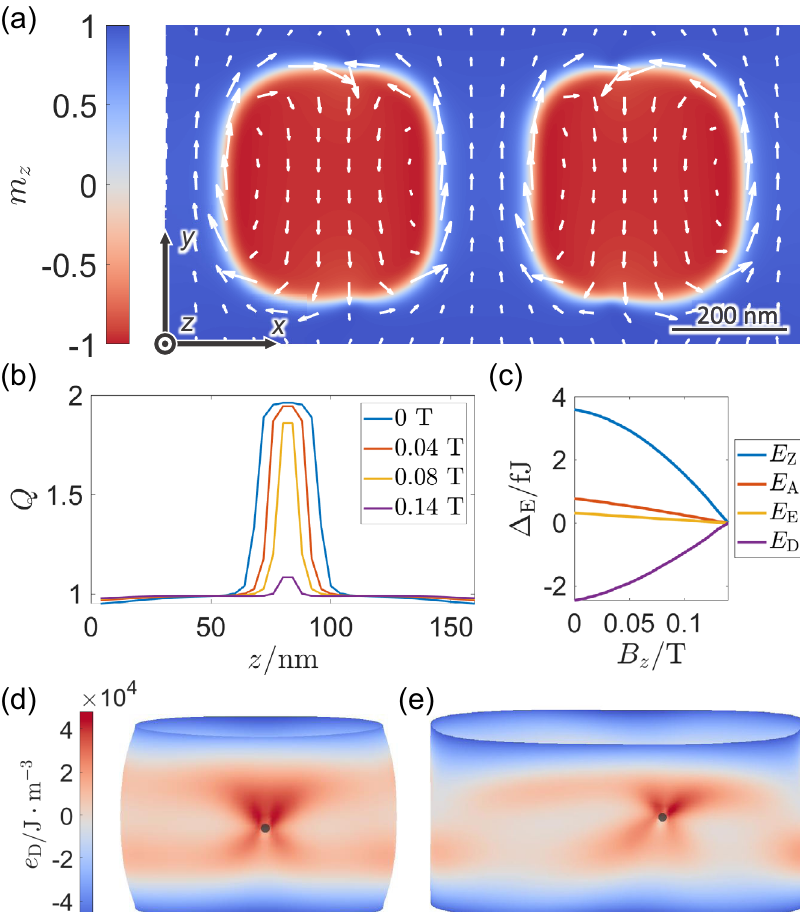
Fig. 4 Transition from bubbles into biskyrmions. a Biskyrmions at the middle plane of a rectangle fi lm. The sample is de fi ned as 1 μ m × 0.5 μ m × 160 nm size with cells of 4 nm × 4 nm × 4 nm. The magnetic easy axis lies in yz -plane. b The dependence of the topological charge Q on the perpendicular position of the left biskyrmion in a during the process of removing B z . c The variations of different energy terms Δ E during the process of removing B z . The initial values at B z = 0.14 T are subtracted from the energy terms for better illustration. E Z , E A , E X , and E D denote Zeeman, anisotropy, exchange, and magnetostatic energy, respectively. d , e The distribution of magnetostatic energy density e D on the contour surface with m z = 0 at B z = 0.14 T and 0 T, respectively. Gray dots depict the location of the